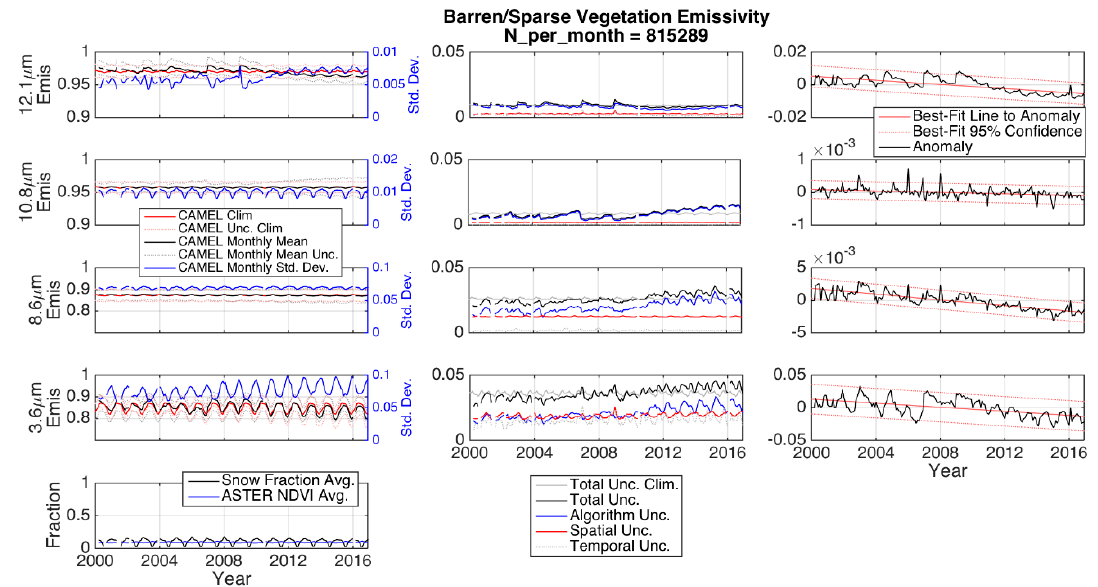
Figure 9. Same as Figure 8 except for the Barren and Sparse Vegetation IGBP category with number of samples per month equal to 815,289.